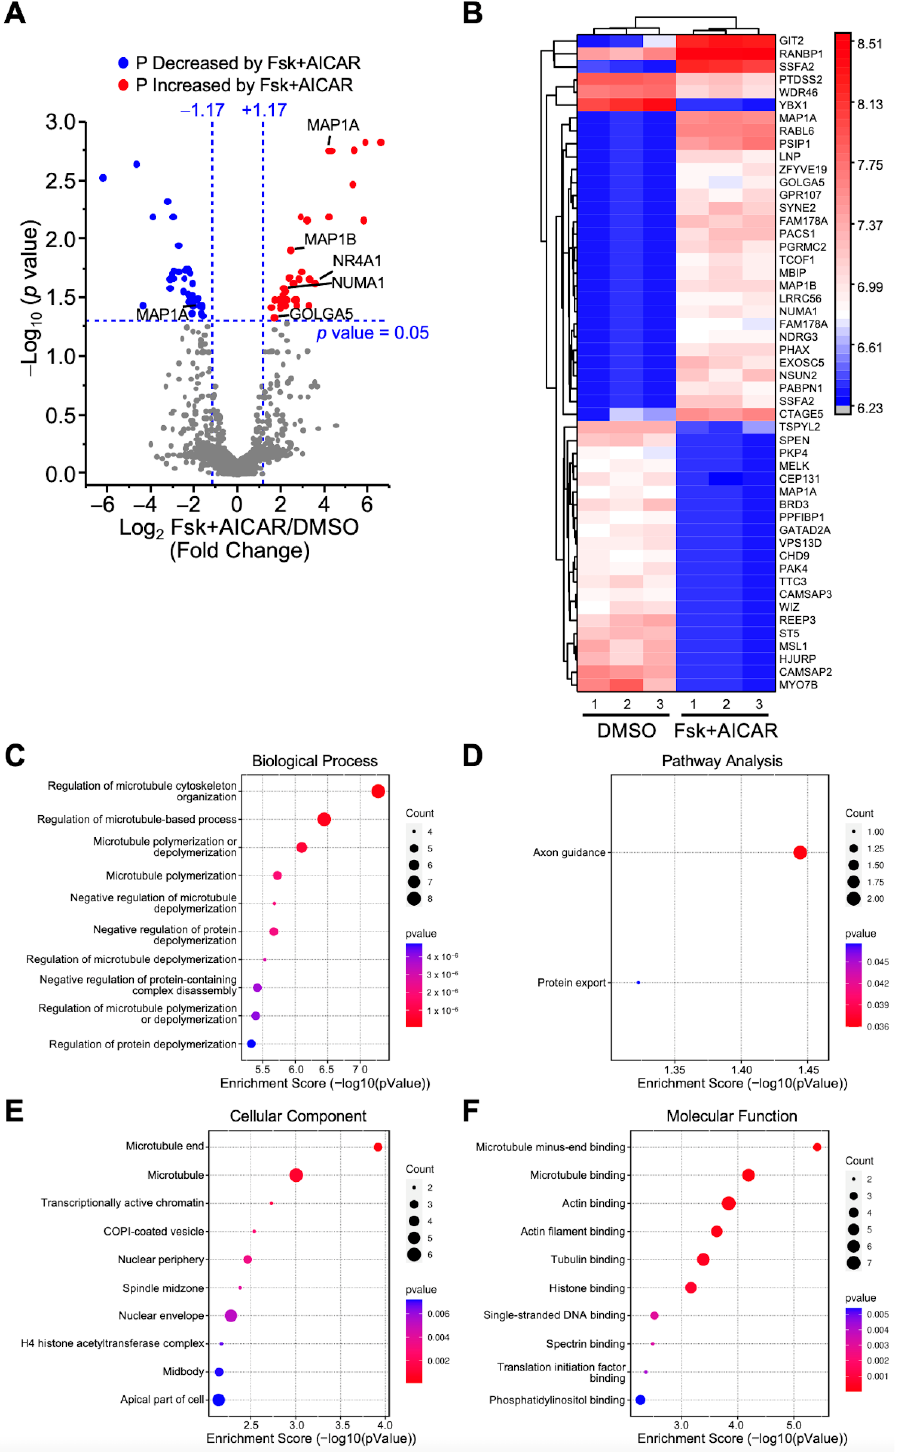
Figure 4. Analysis of differentially phosphorylated proteins in MA-10 Leydig cells in response to Forskolin+AICAR. LC-MS/MS was performed on enriched phosphopeptides extracted and digested from MA-10 Leydig cells treated with DMSO (control) or Fsk+AICAR (10 µM and 1 mM, respec- tively) for 1 h. Phosphorylated proteins were then quantified and compared between treatments.